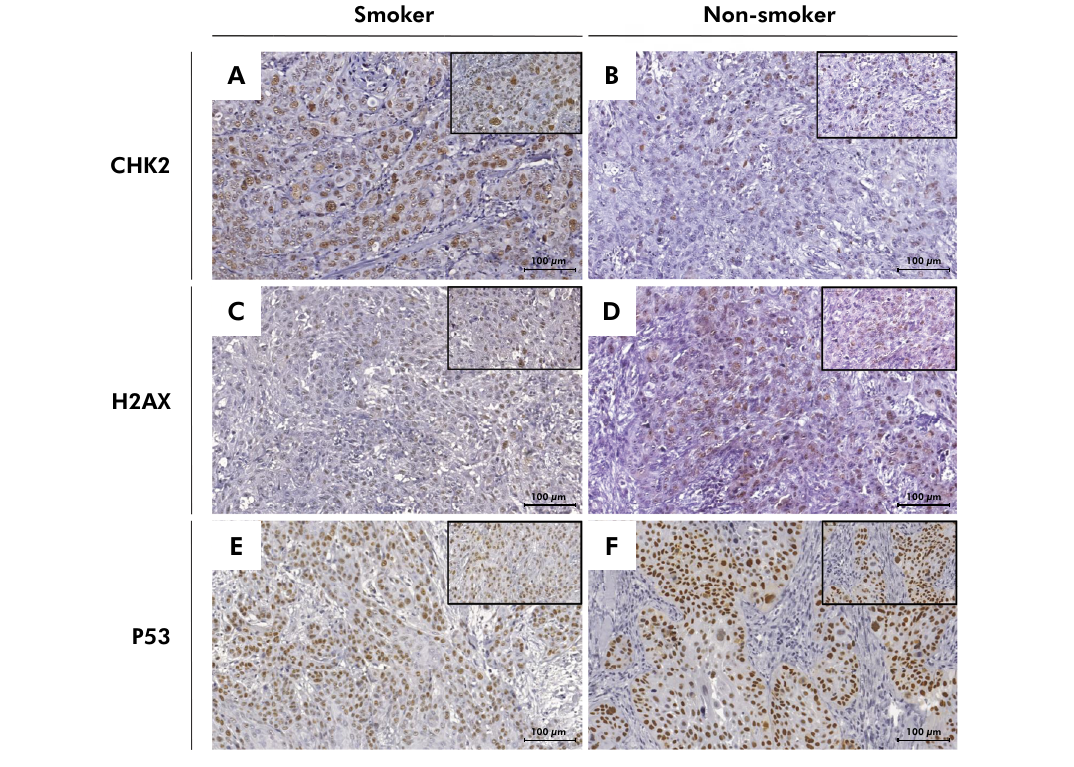
Figure 2. CHK2 staining in a smoker (A) and in a non-smoker (B). H2AX staining in a smoker (C) and in a non-smoker (D). P53 staining in a smoker (E) and in a non-smoker (F). Immunohistochemistry, x 200 and x